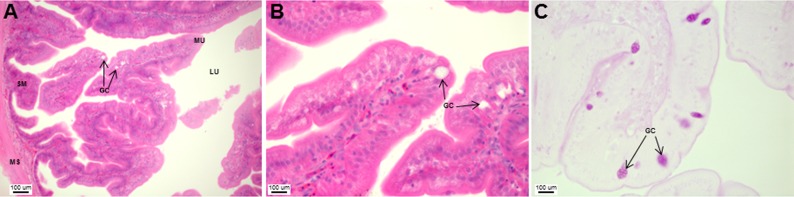
Asian seabass pyloric caeca resemble the intestine histologically, but with much fewer goblet cells.Transverse section of the pyloric caeca of Asian seabass stained with H&E (A and B; 10X and 63X, respectively) and PAS-AB pH 2.5 (C; 63X magnification). Abbreviations: lumen (LU), mucosa (MU), goblet cells (GC), submucosa (SM), and muscularis (MS).